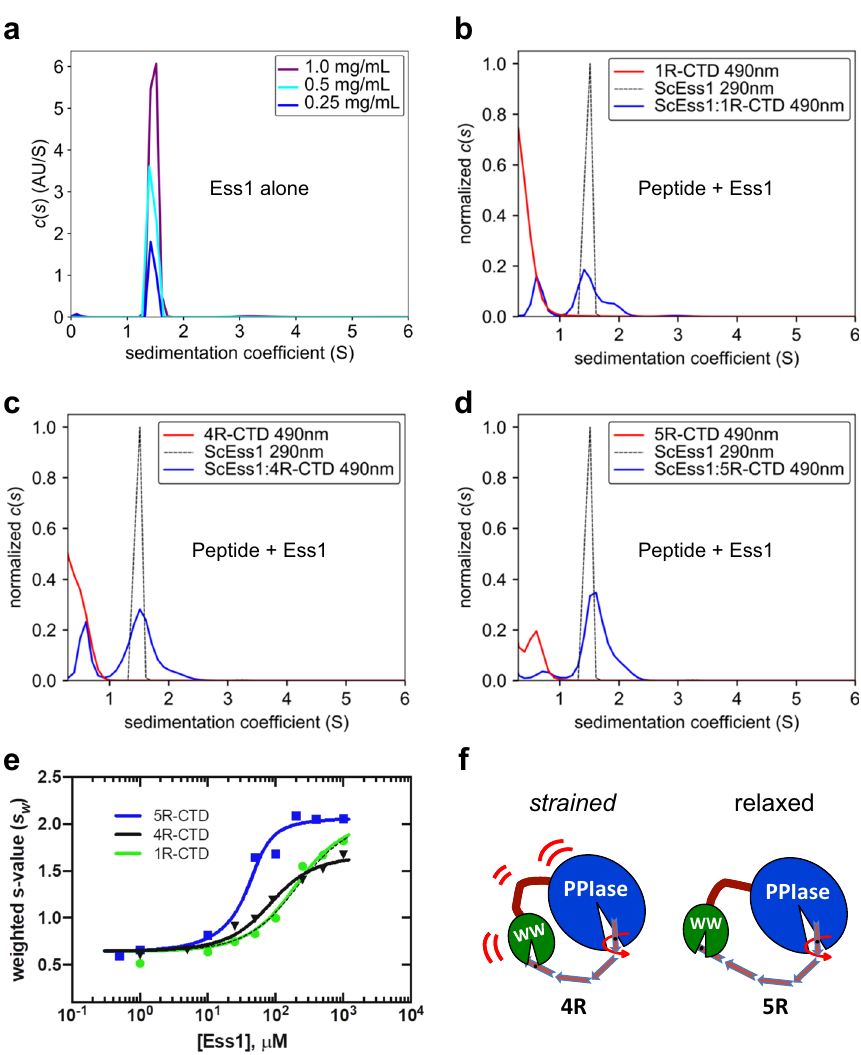
Fig. 4 SV-AUC reveals potential cooperative binding of Ess1 to a 5-repeat CTD peptide. a Ess1 alone at three different concentrations, showing it is a stable, monodisperse monomer. b – d Binding of Ess1 to FITC-labeled CTD peptides as revealed by c ( s ) distributions: b FITC- 1R -CTD peptide, c FITC- 4R - CTD peptide, and d FITC- 5R -CTD peptide. Each panel shows the position of 200 μ M Ess1 alone at 290 nm (black dotted line), or 20 μ M CTD peptides alone (red line) or a mixture of Ess1 + CTD peptide at 10:1 (blue line) at the indicated wavelenths of absorbance. Note the larger fraction of the 5R peptide migrating at the bound position vs. the 4R peptide. c vs. d e s w -isotherms of 50 μ M 1R-CTD (green), 4R-CTD (black) or 5R-CTD (blue) with a titration of Sc Ess1 (0.5 – 1000 μ M). The black dashed line shows the fi t to the 4R-CTD data with the constrained maximum s binding to 4-repeat and 5-repeat CTD peptides phosphorylated at the terminal Ser5-Pro6 repeats. The model is based on the higher af fi nity of the 5R peptide compared to the 4R peptide (panels c vs. d ; e ), and supported by SV-AUC and NMR chemical-shift data (see with an average K d of 46.8 ± 74 μ M. Curiously, variable 4R- binding af fi nities were reported across the protein, giving rise to the high standard deviation for the K d value (Fig. 5b). While most of the residues in the WW domain titrated with 5R-like binding af fi nity, residues K23 and H35 did not, together with PPIase residues D103, N108, D119, and Y123 (Fig. 5b, Table S3). Importantly for the 4R titration, we observed non-linear or distinct (from 1R and 5R) chemical shift trajectories for WW residues N30 and H35, linker α -helix residue L49, and PPIase residues G130 and D143 (Figs. 5c and S9), suggesting a secondary event occurs during the course of the titration. We suspect that the 4R peptide is slightly shorter than the optimum length for two-site binding, and consequently Ess1 may undergo a slight conformational change across the protein to accommodate it (Fig. 4f), in agreement with SV-AUC data presented above. This would also explain the lower apparent binding af fi nity for 4R vs.